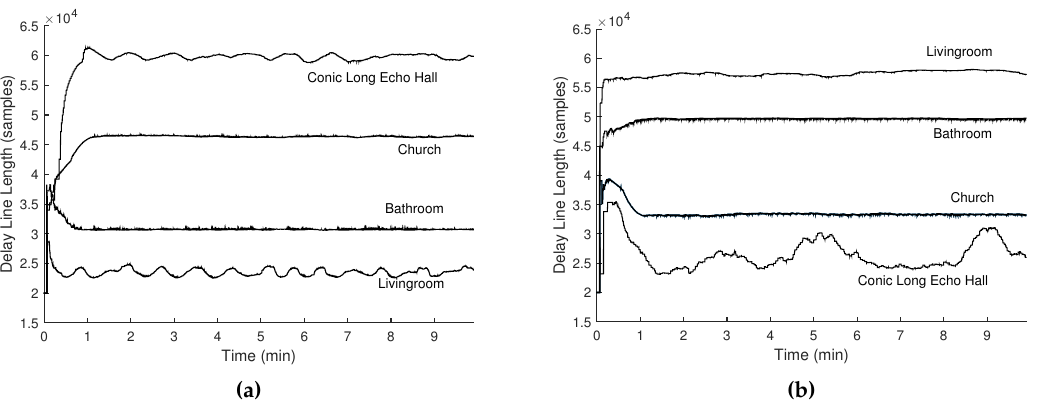
Figure 5. Delay line length curves simulated using impulse response data of several locations with different reverberant characteristics (measured in Table 2), using the ( a ) proportional ( L 1 ) and ( b ) reflected ( L 2 ) mappings. Table 2. Comparison of the reverberant characteristics measured by RT60 (the reverberation time over